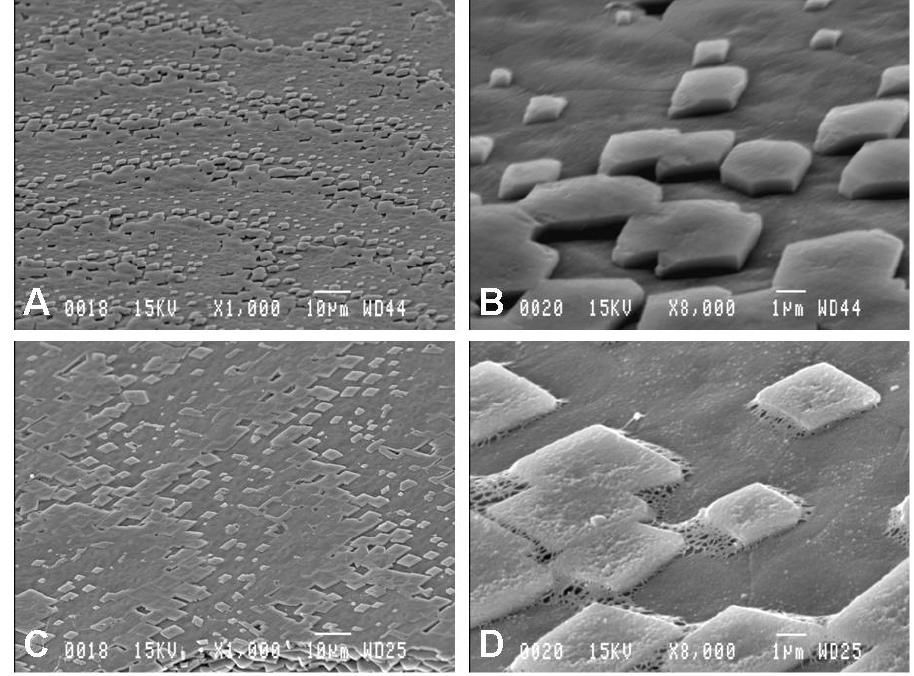
Figure 3. SEM images of nacre surface of pearl oyster kept at a depth of 30 m (A: ×1,000; B: ×8,000) and of 39 m (C: ×1,000; D: ×8,000).